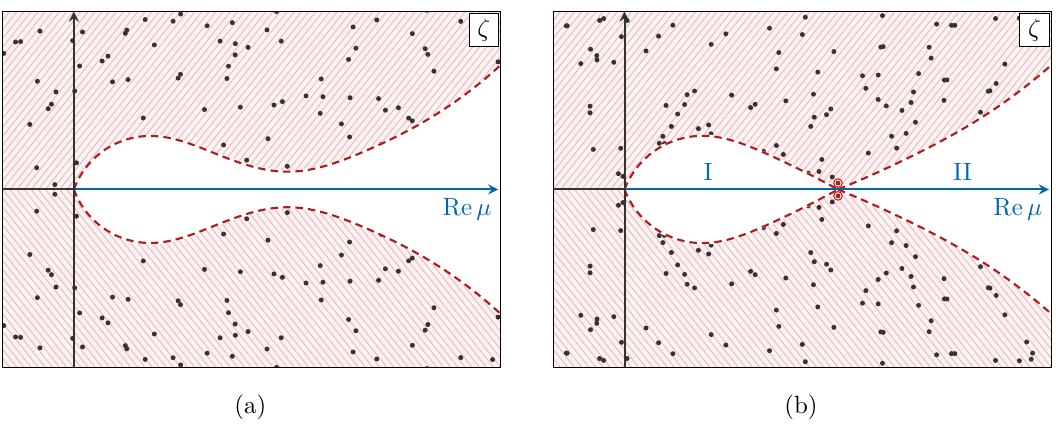
Figure 2. Partition functions zeros (some of which are shown here as black dots) form regions in the complex fugacity plane (shown in white) in which we can analytically continue the pressure P β, V ( ζ ) . In the thermodynamic limit, these regions are bounded by a continuum of zeros beyond which we cannot analytically continue, here represented by the dashed red lines. In the absence of a phase transition (left), this region of analyticity encompasses the entire physical domain and thus the pressure is smooth for all real values of the chemical potential. The system can also be tuned so that the zeros pinch the real axis (right), dividing the physical domain into two distinct phases (I and II), unrelated by analytic